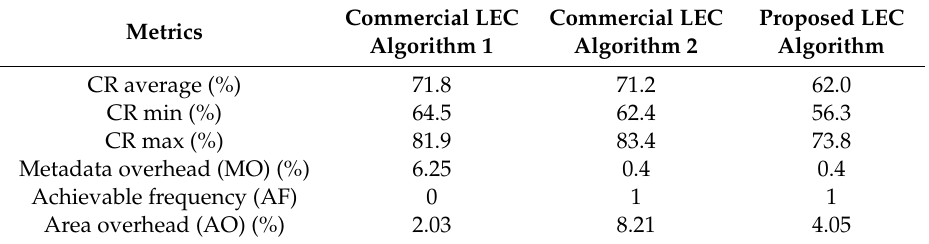
Table 11. Performance comparison according to the proposed metrics.